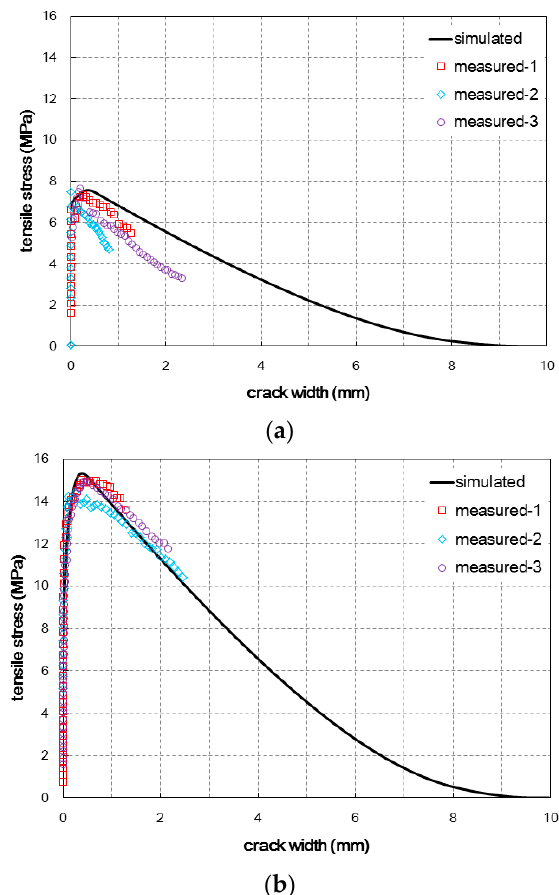
Figure 10. Comparison of the simulated and measured tensile behaviors for ( a ) Method A and ( b ) Method B.